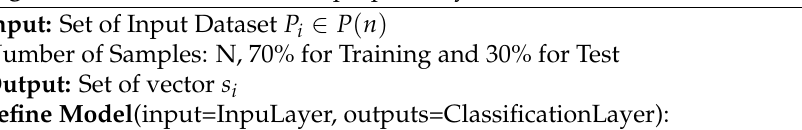
Figure 3. ( a ) Working flow architecture. ( b ) Grain model. ( c ) CNN feature extraction module. ( d ) Classification module ( e ) Convolutional layer-based transformer. ( f ) MLP convolution. Algorithm 1 Pseudocode of the proposed